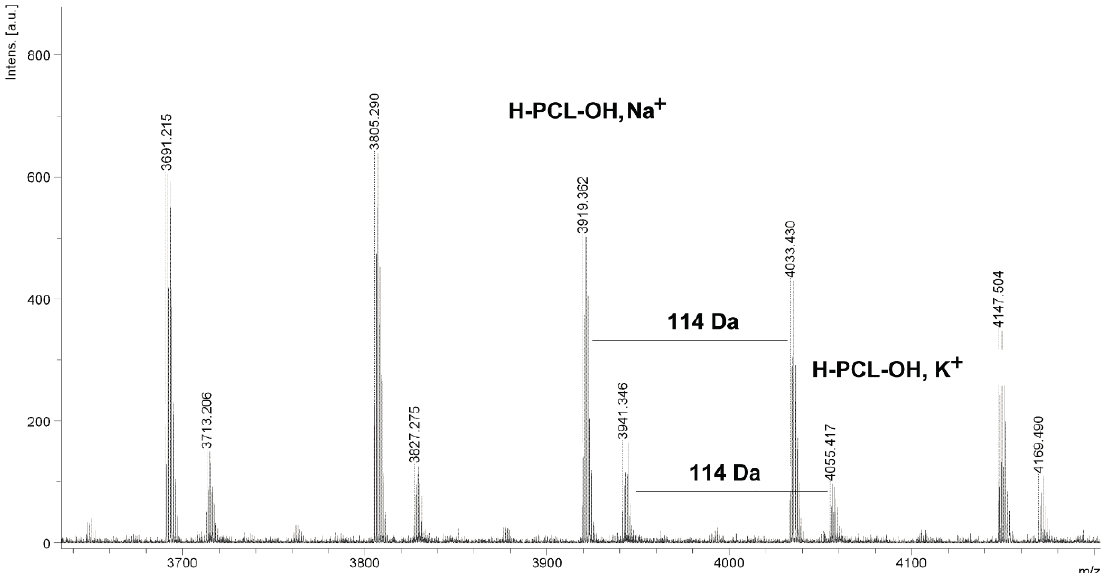
Figure 5. MALDI TOF MS spectrum of PCL obtained in the presence ZnEt 2 /GAc catalytic system ( PCL-5 ).